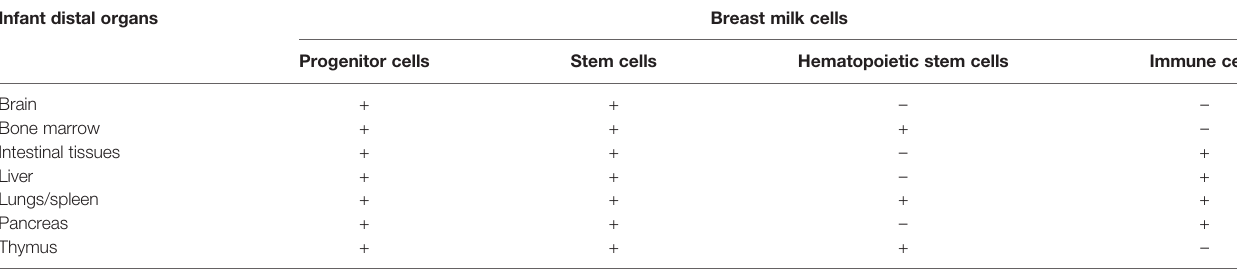
TABLE 1 | Infant ’ s organs in which speci fi c cells of HBM are found. Infant distal